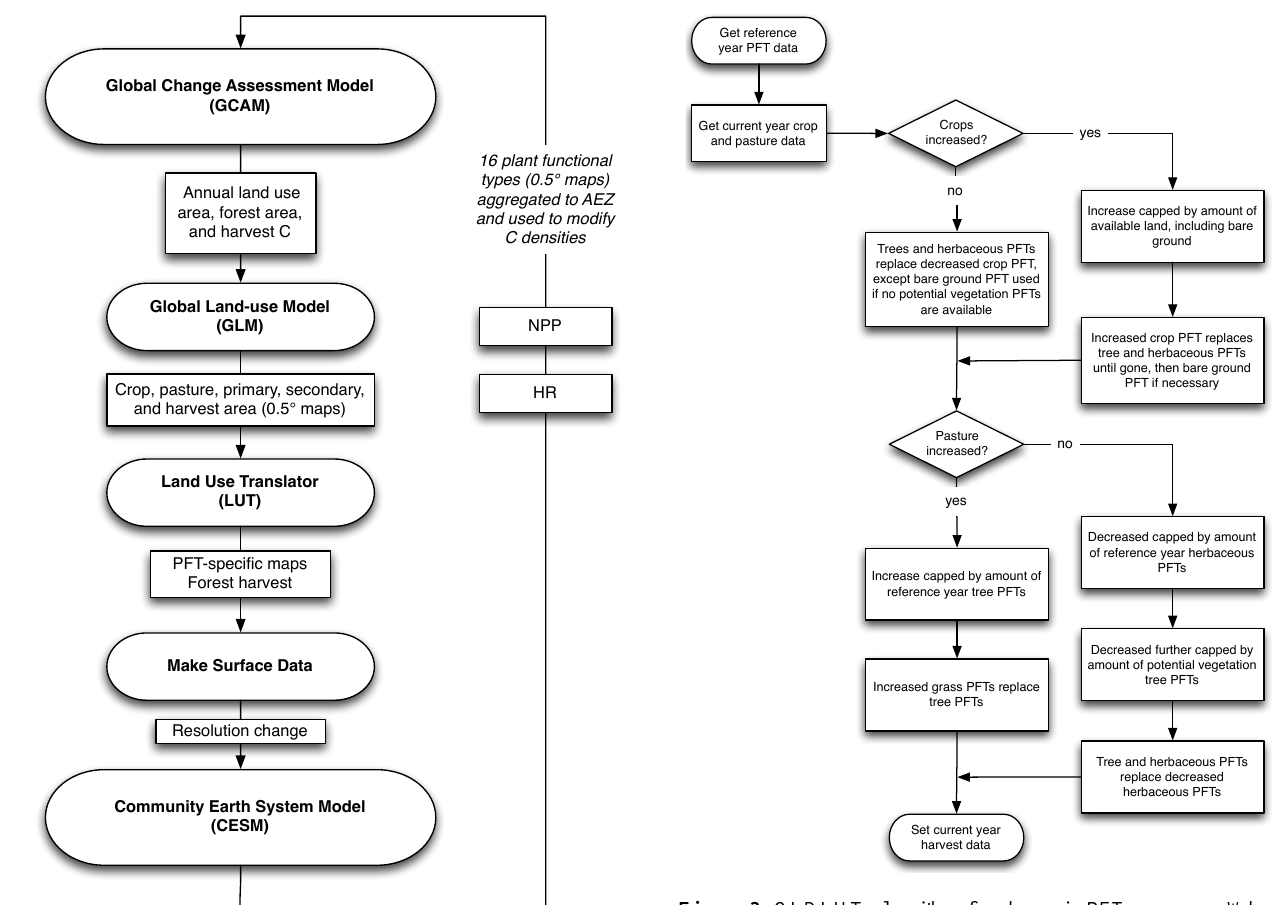
Figure 3. OLDLUT algorithm for dynamic PFT coverage. When cropland and pasture decrease, non-crop PFTs are added in propor- tion to potential vegetation fractions. When cropland and pasture in- crease, non-crop PFTs are removed in proportion to reference year